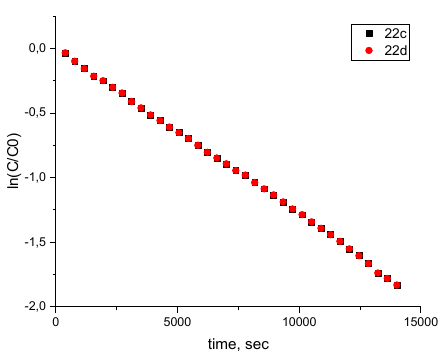
Figure 6. Kinetics of decomposition of HPNs 22c and 22d in diluted and oxygen-free toluene solutions.